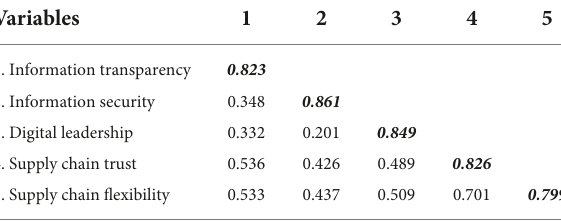
TABLE 2 Correlations and discriminant validity among the constructs.